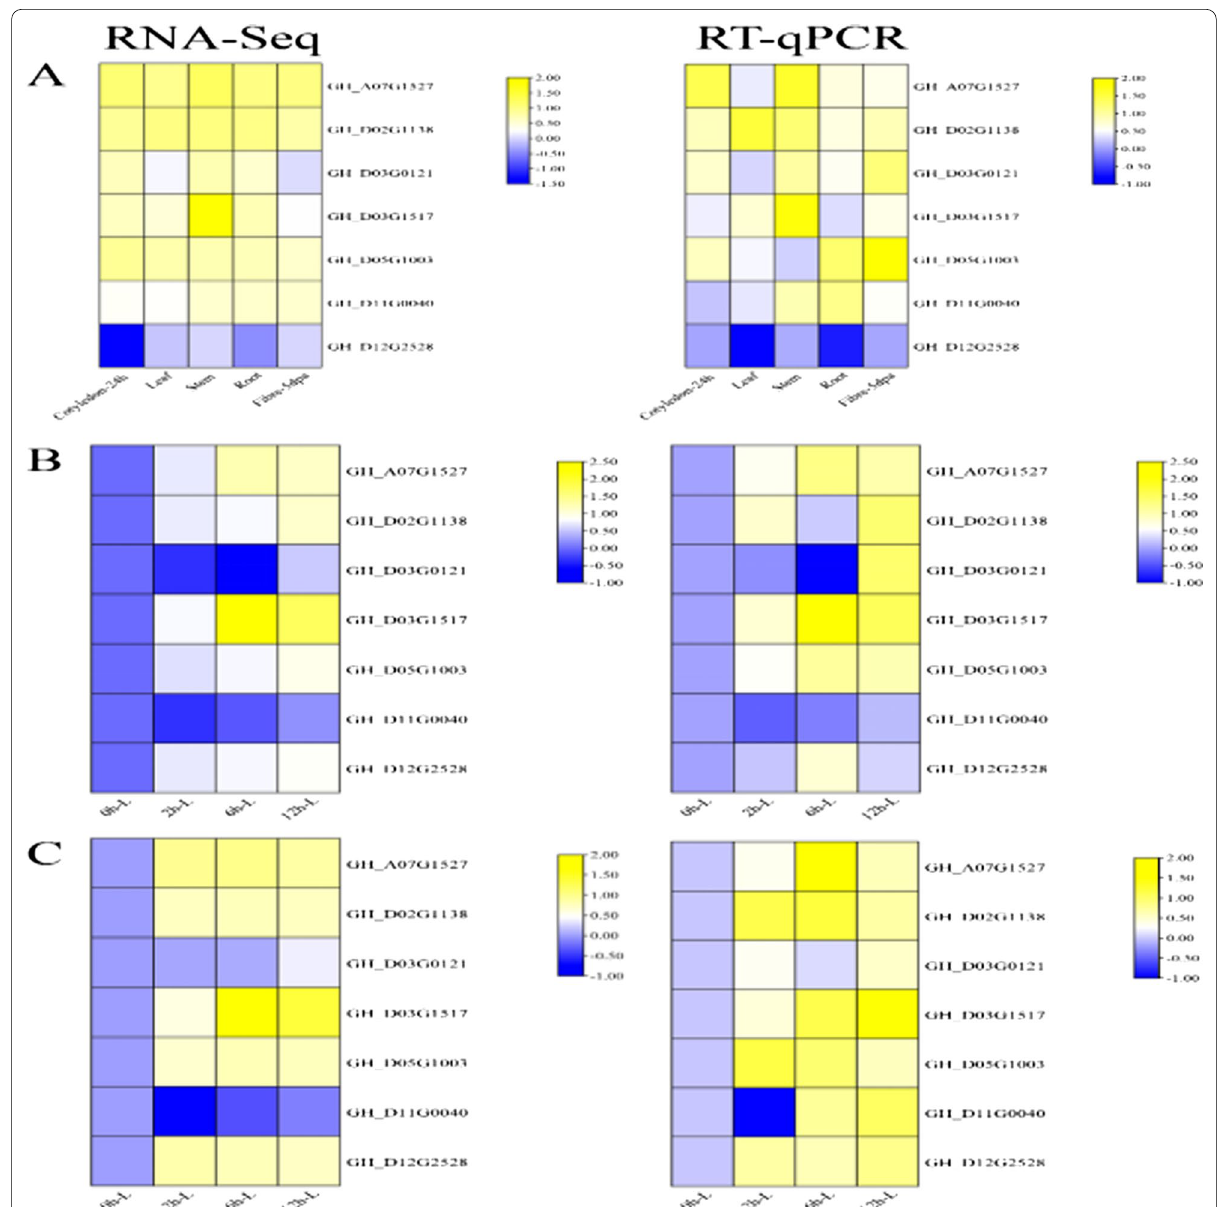
Fig. 7 RNA sequencing analysis and qRT-PCR analysis of the 7 cotton GHMAPK genes. A) gene expression pattern in cotton tissues; B) drought stress gene expression pattern; C) salt stress gene expression pattern. The relative expression was determined using the CT method with actin1 serving as a housekeeping gene. The data represents the mean average of three replicates. The TB Tools software was used to build the heat map (shown by log 10 values). Yellow indicates upregulation, blue indicates downregulation, and white indicates no